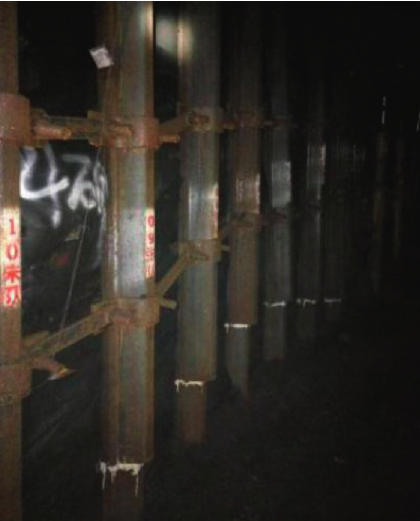
Figure 14: Effect diagram of nonpillar gob-side entry retaining by roof cutting